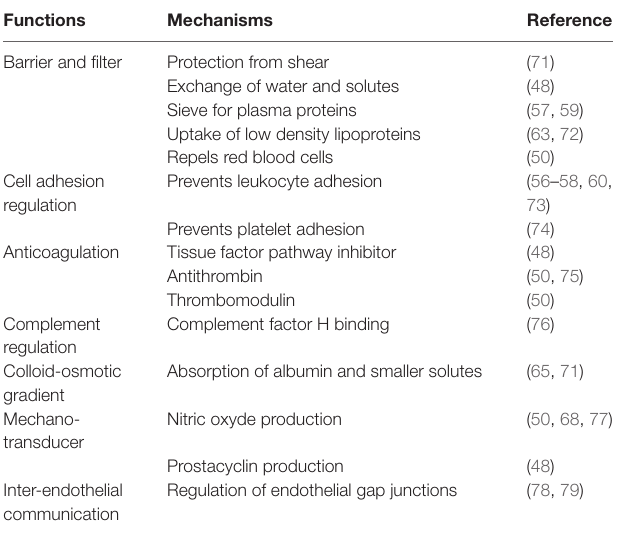
TABLe 1 | Some recognized functions of the endothelial glycocalyx (48–50, 52, 69,